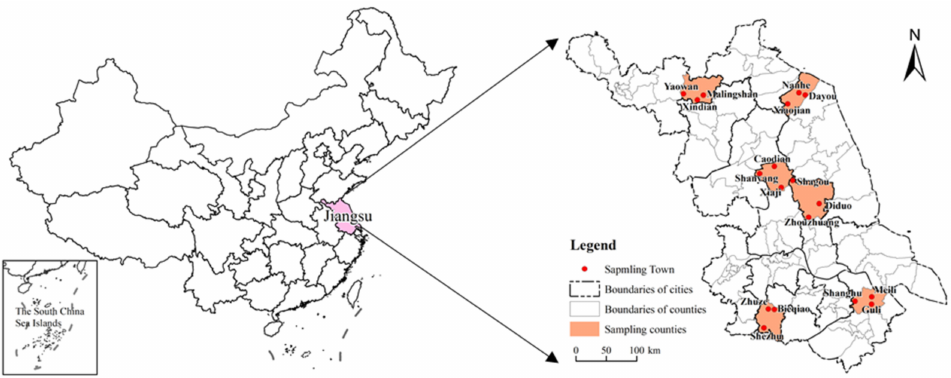
Figure 1. Locations of survey